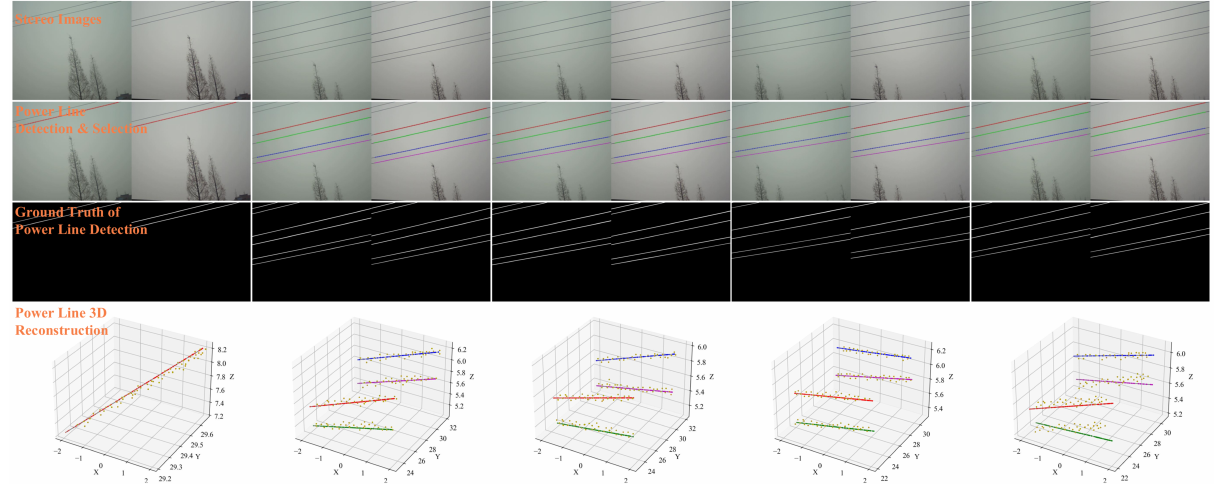
Figure 12. Power lines 3D reconstruction results of several continuous frames.(Discrete points indicate the corresponding LiDAR